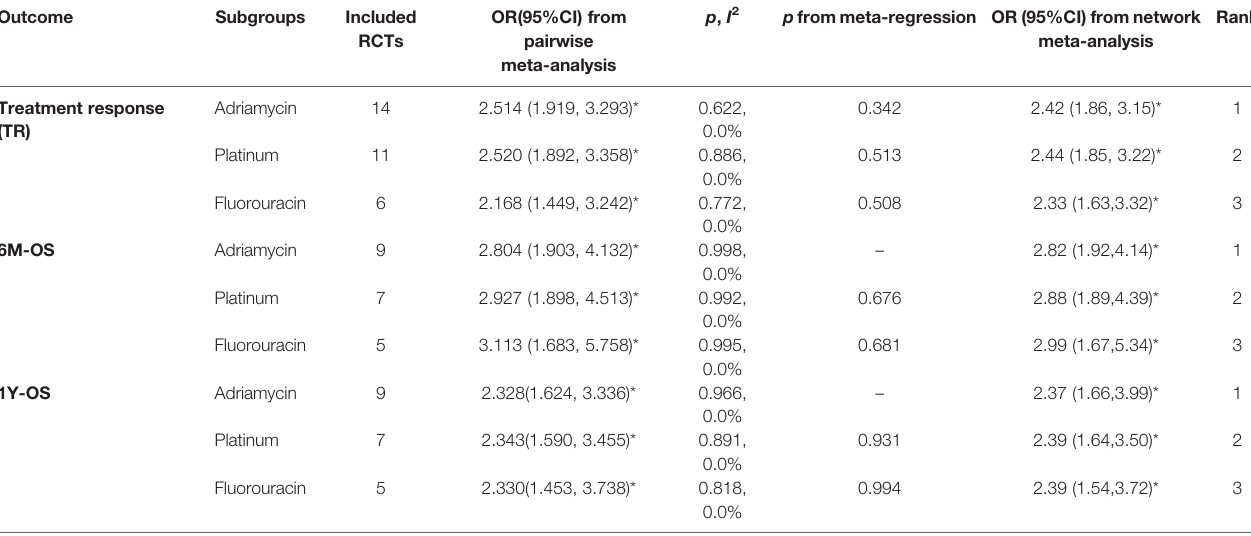
TABLE 3 | Ef fi cacy of TACE+apatinib versus TACE in treatment response and overall survival, which was subgroup analyzed by classi fi cation of TACE agents. Outcome Subgroups Included